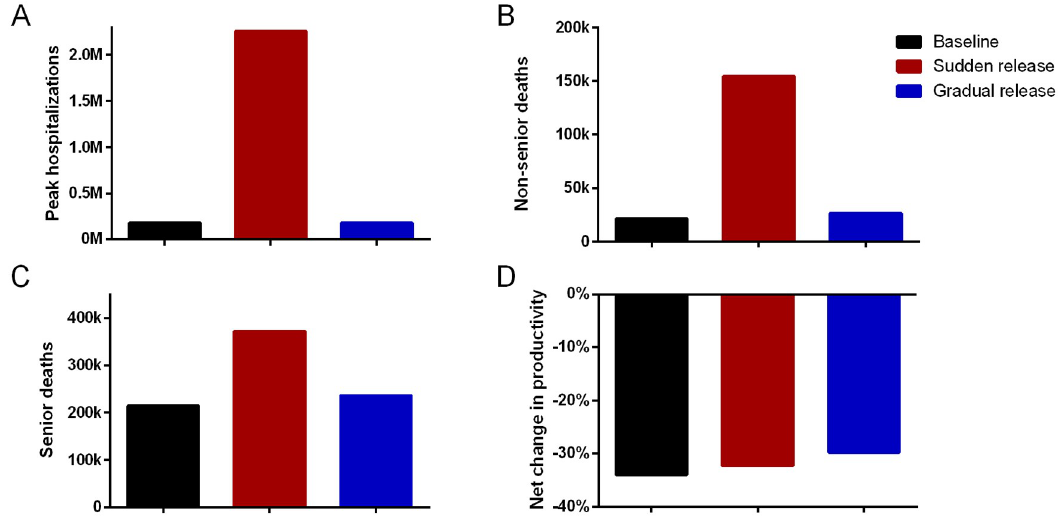
Fig 5. Comparison of all scenarios. ( A ) Peak number of hospitalizations. ( B ) Non-senior deaths. ( C ) Senior deaths. ( D ) Net change in productivity.